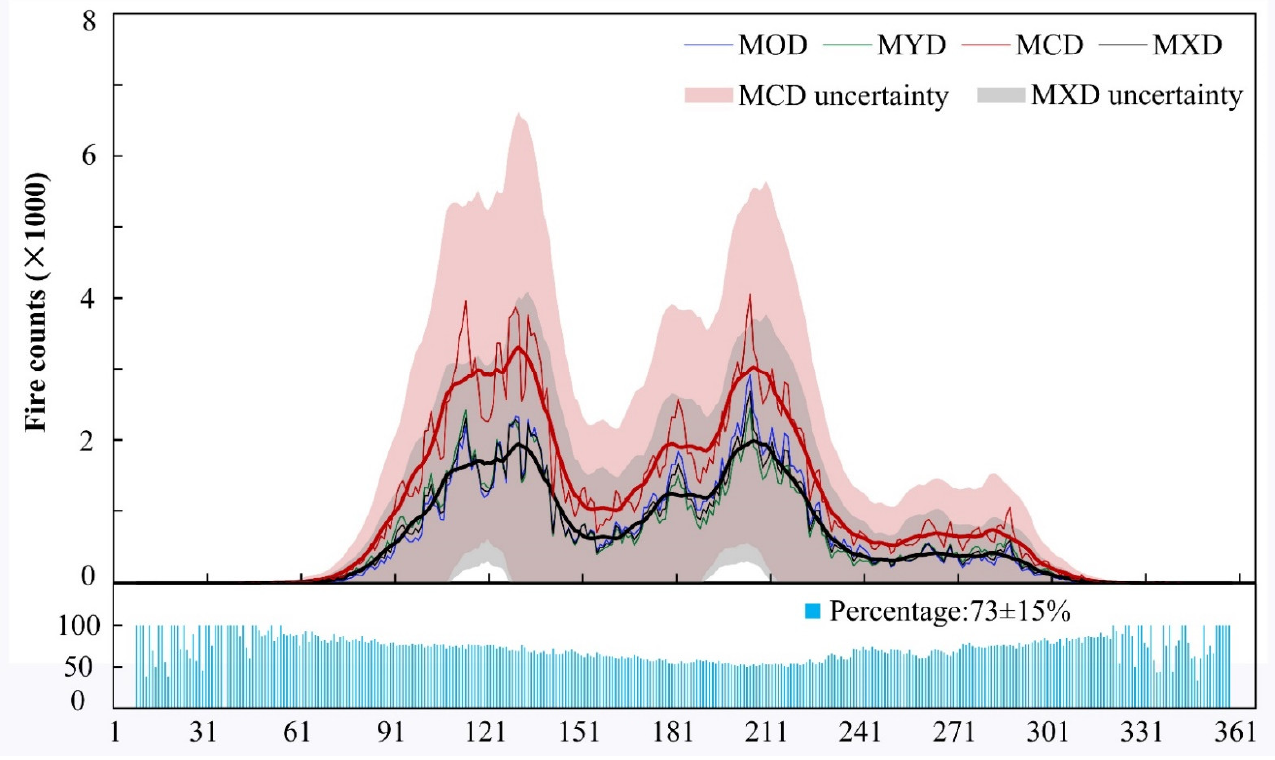
Figure 2. Seasonal cycle of multi-year mean daily active fire counts in Northern Eurasia (NEA). Colored lines represent the daily fire counts from single satellites (blue-MOD, green-MYD), the average of both datasets (black-MXD), and the combined dataset (red-MCD).